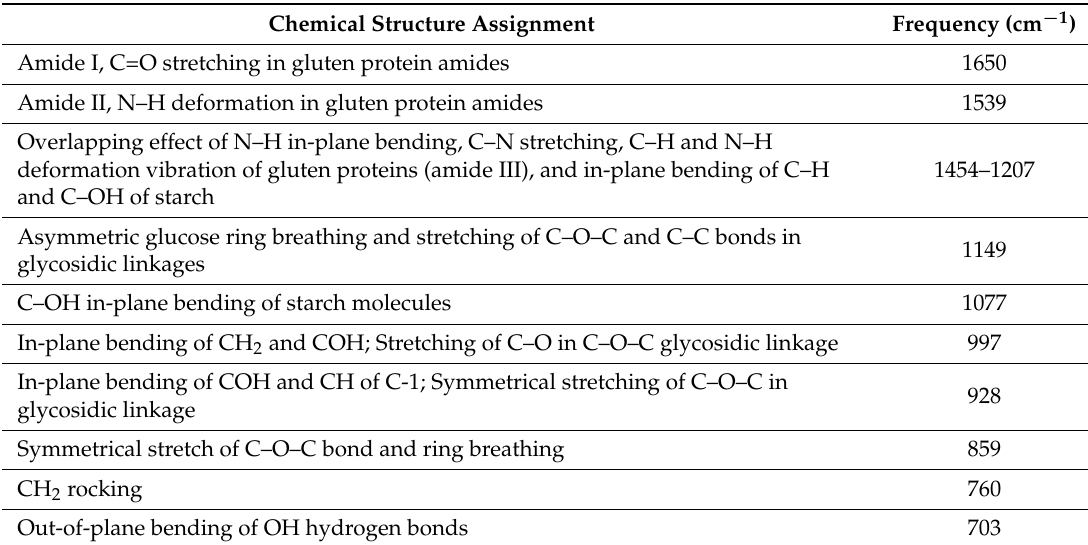
Table 3. Assignment of the infrared bands of the WF sample